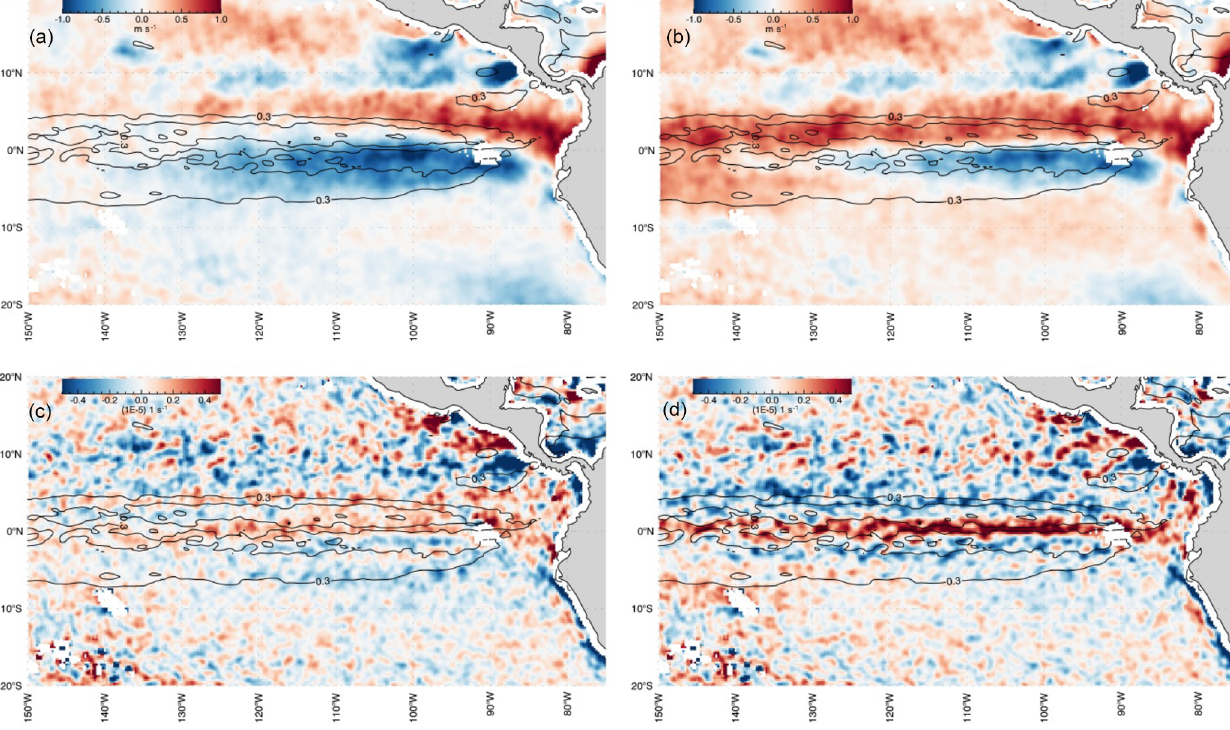
Figure 16. Eastern tropical Pacific: annual differences in mean wind speed (a, b) and mean stress curl (c, d) between ASCAT and ERA5 before (a, c) and after (b, d) the ocean current correction. The contours are annual mean ocean surface